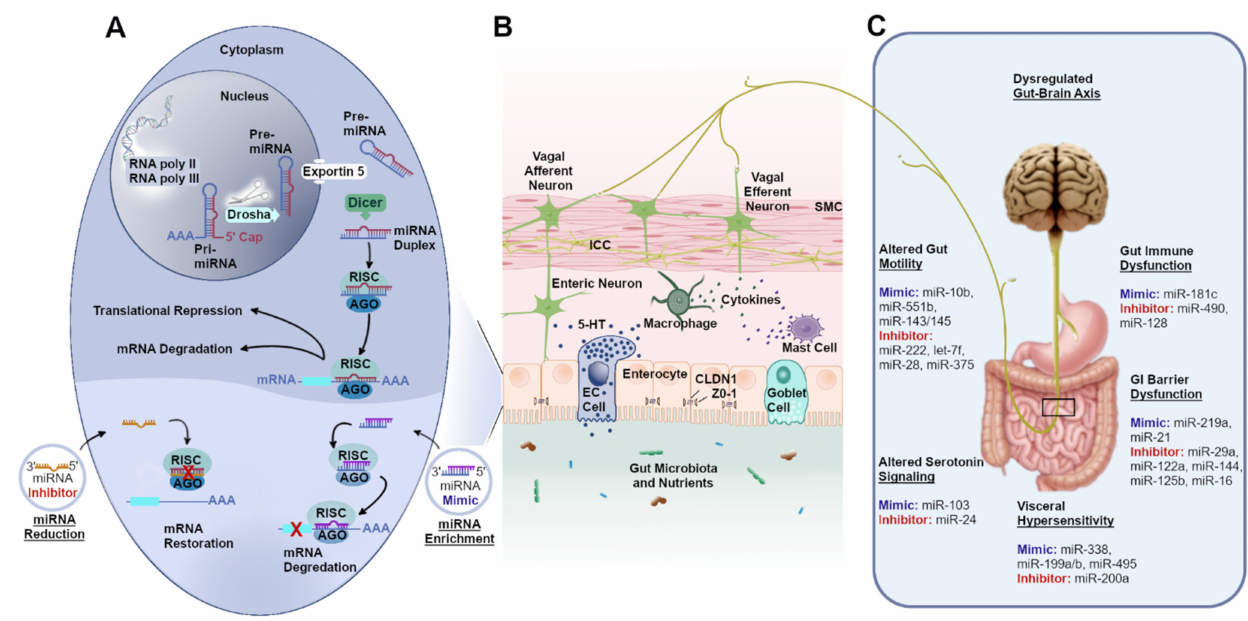
Figure 1. miRNA mediated pathophysiological mechanisms and potential therapeutic alternatives for DGBIs. ( A ). miRNA biogenesis and miRNA therapeutic approaches to reduce or enhance miRNA levels leading to mRNA restoration or mRNA degradation/translational repression, respectively, ( B ). Dysregulated miRNAs are evidenced in gastrointestinal pacemaking cells, immune cells, intestinal epithelial cells, and enteric neurons, ( C ). Possible miRNA therapeutics based on pathophysiological mechanisms. Abbreviations: AGO, argonaute; CLDN1, claudin-1; EC cell, enterochromaffin cell; ICC, interstitial cell of Cajal; miRNA, microRNA, mRNA, messenger RNA; RISC, RNA-induced silencing complex; SMC, smooth muscle cell; ZO-1, zonula occludens; 5-HT,